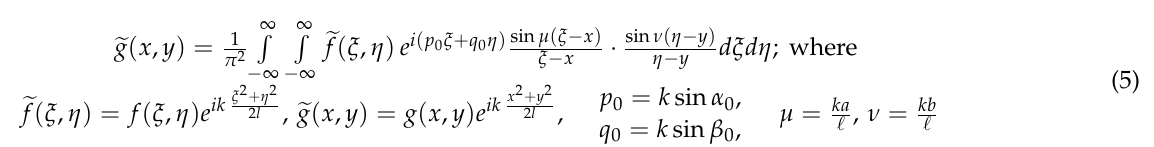
Figure 11. Spatial spectrum of the test object ( a ) and superposition of four holographic image spectra taken with four different angles of illumination ( b ) and synthesized image of the object ( c ). 3.2. Visualization of Subsurface Objects The above analysis can be generalized to the case of a planar electrically contrasting object immersed in a layered inhomogeneous dielectric subsurface medium with slowly changing refractive index